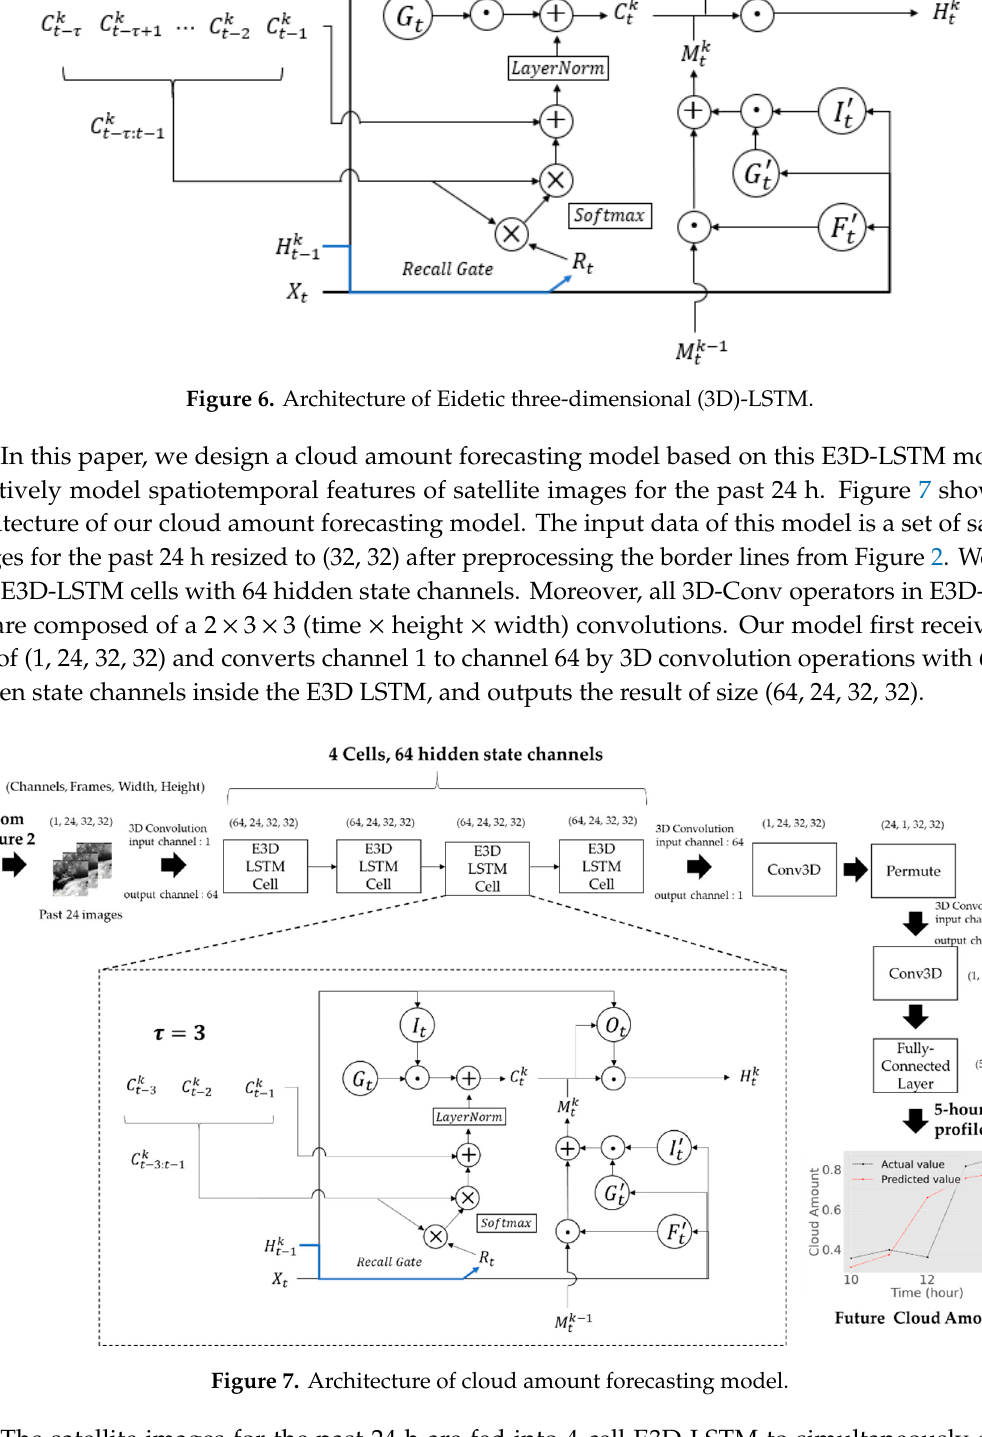
Figure 7. Architecture of cloud amount forecasting model.